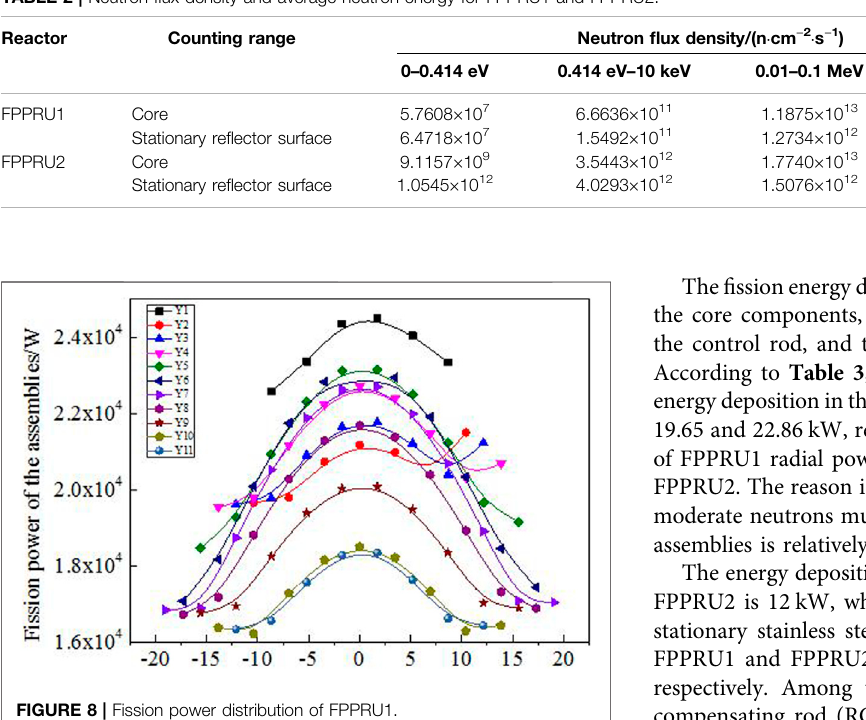
FIGURE 8 | Fission power distribution of FPPRU1.